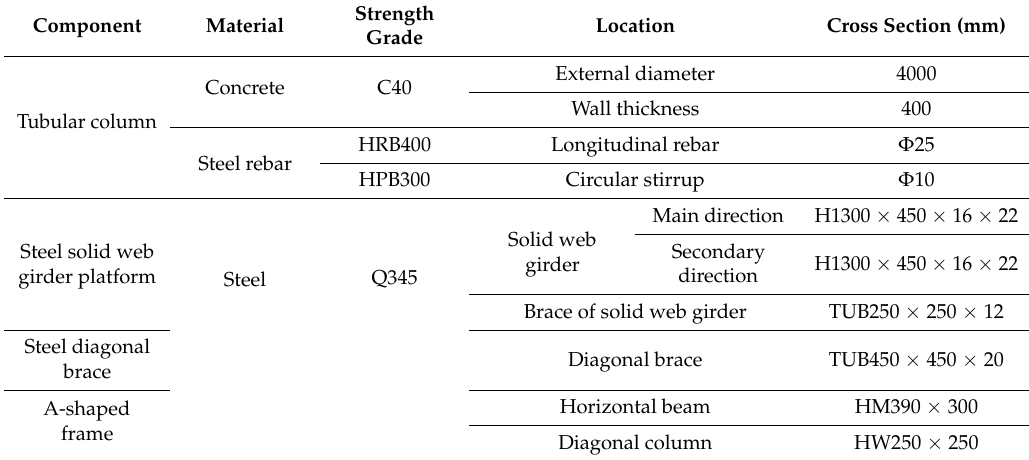
Table 1. Strength grades of materials and cross sections of the main